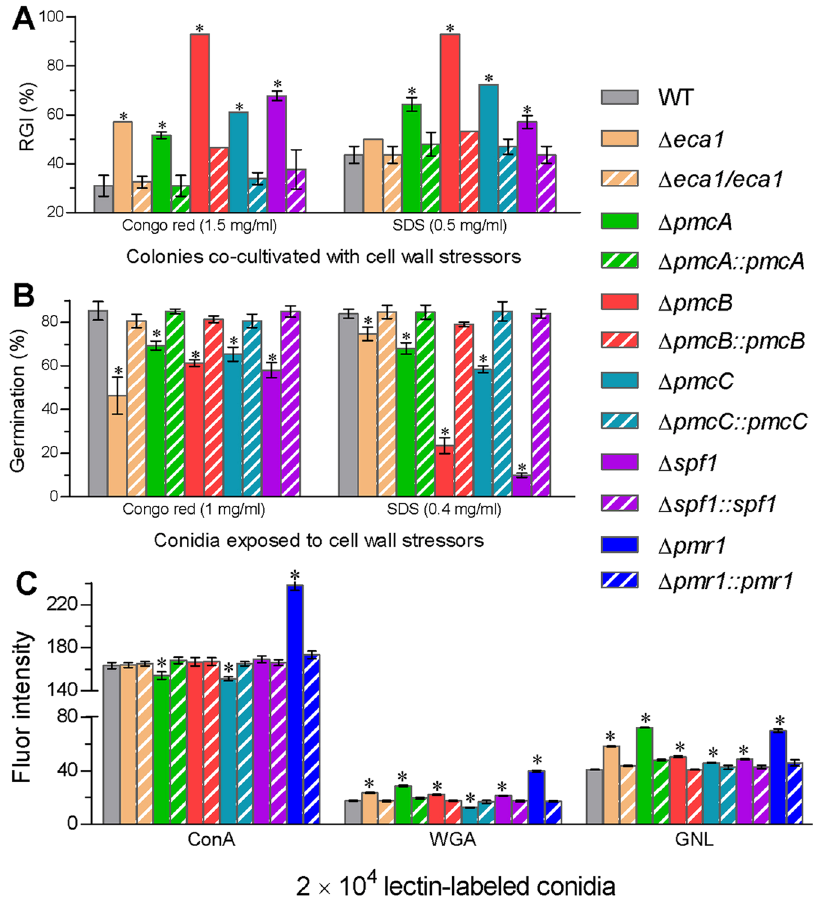
Figure 6. The CA pumps sustaining cell wall integrity in B . bassiana . ( A , B ) Relative inhibition of Congo red and SDS to fungal colony growth and conidial germination, respectively, at 25 °C on a medium containing a sensitive concentration of each cell wall perturbing chemical as indicated. ( C ) Fluorescence readings for the changes of cell wall components in the ConA-, WGA- and GNL-labeled conidia analyzed via flow cytometry. The asterisked bars in each bar group differ significantly from those unmarked (Tukey’s HSD, P < 0.05). Error bars: SD from three